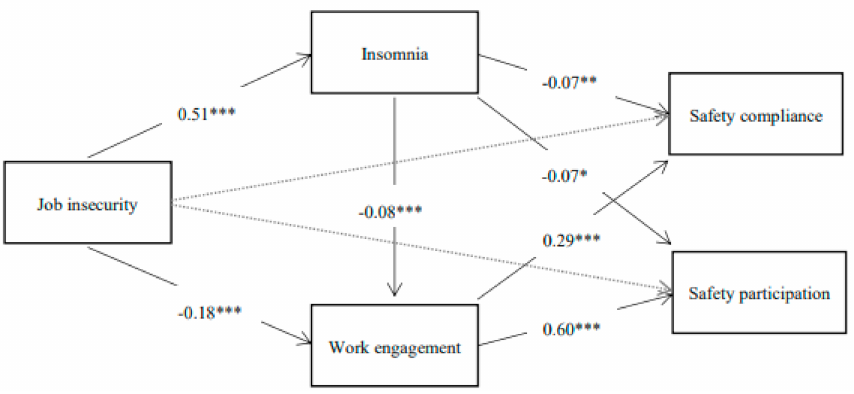
Figure 1. Multiple mediation effect model. (Note: *** p < 0.001; ** p < 0.01; * p <